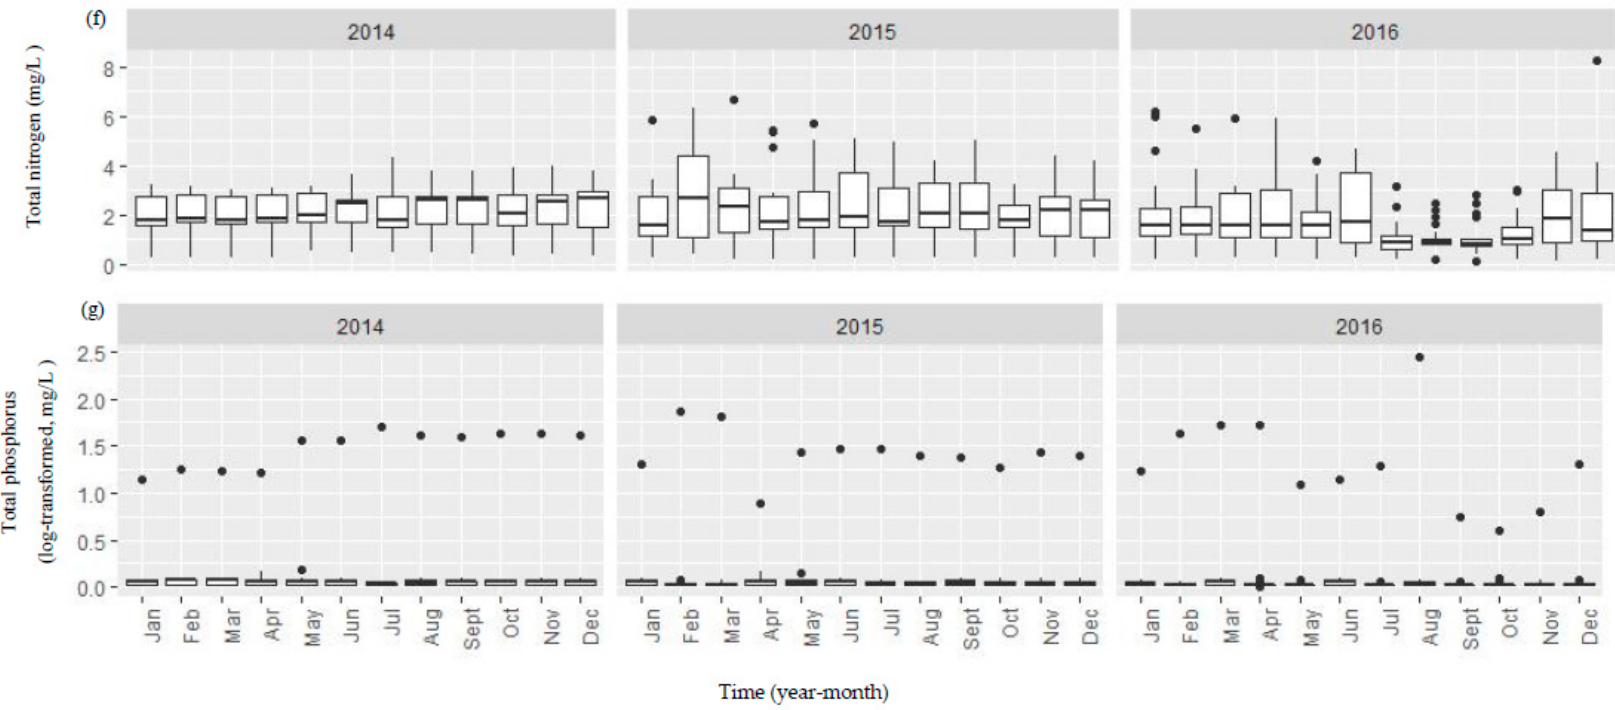
Figure A1. Boxplots showing both temporal and spatial variation of the selected environmental variables (a–g) between 2014 and 2016 in the Danjiangkou Reservoir. ( a – g ) boxplots were the plots of T, CD, COD, SD, pH, TN, and TP variables, respectively. The vertical line includes a range of variation and the data points outside the range indicated as solid dots are considered as outliers. The box includes the data between first and third quantiles and the median (black bar). The horizontal black bar in Figure A1b indicates missing conductivity data between January and May 2016.